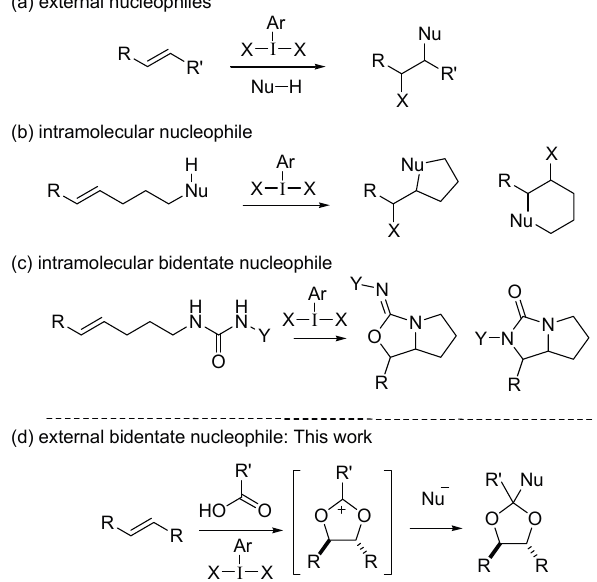
Figure 1. Difunctionalization of alkenes with hypervalent iodine(III) using ( a ) external nucleophiles; ( b ) intramolecular nucleophile; ( c ) intramolecular bidentate nucleophile; and ( d ) external bidentate